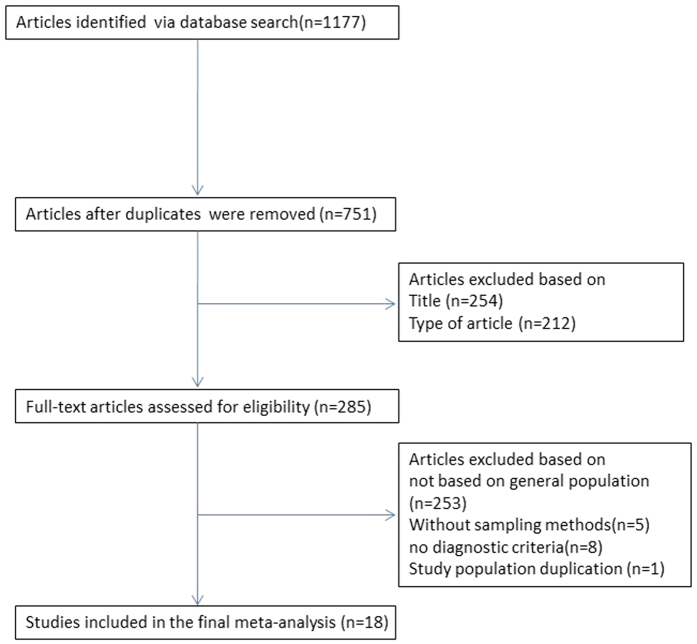
Flow chart of the article selection process to evaluate the prevalence of kidney stones in mainland China.